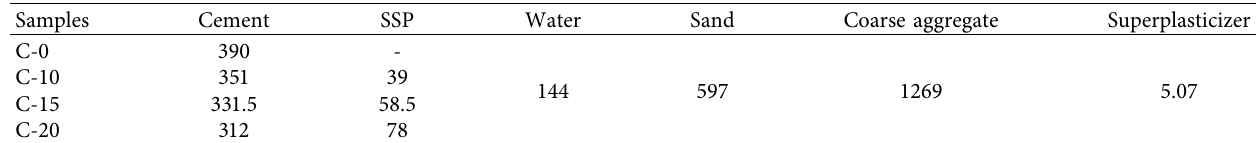
Table 4: Mix proportions of concrete ( kg ∗ m − 3 )